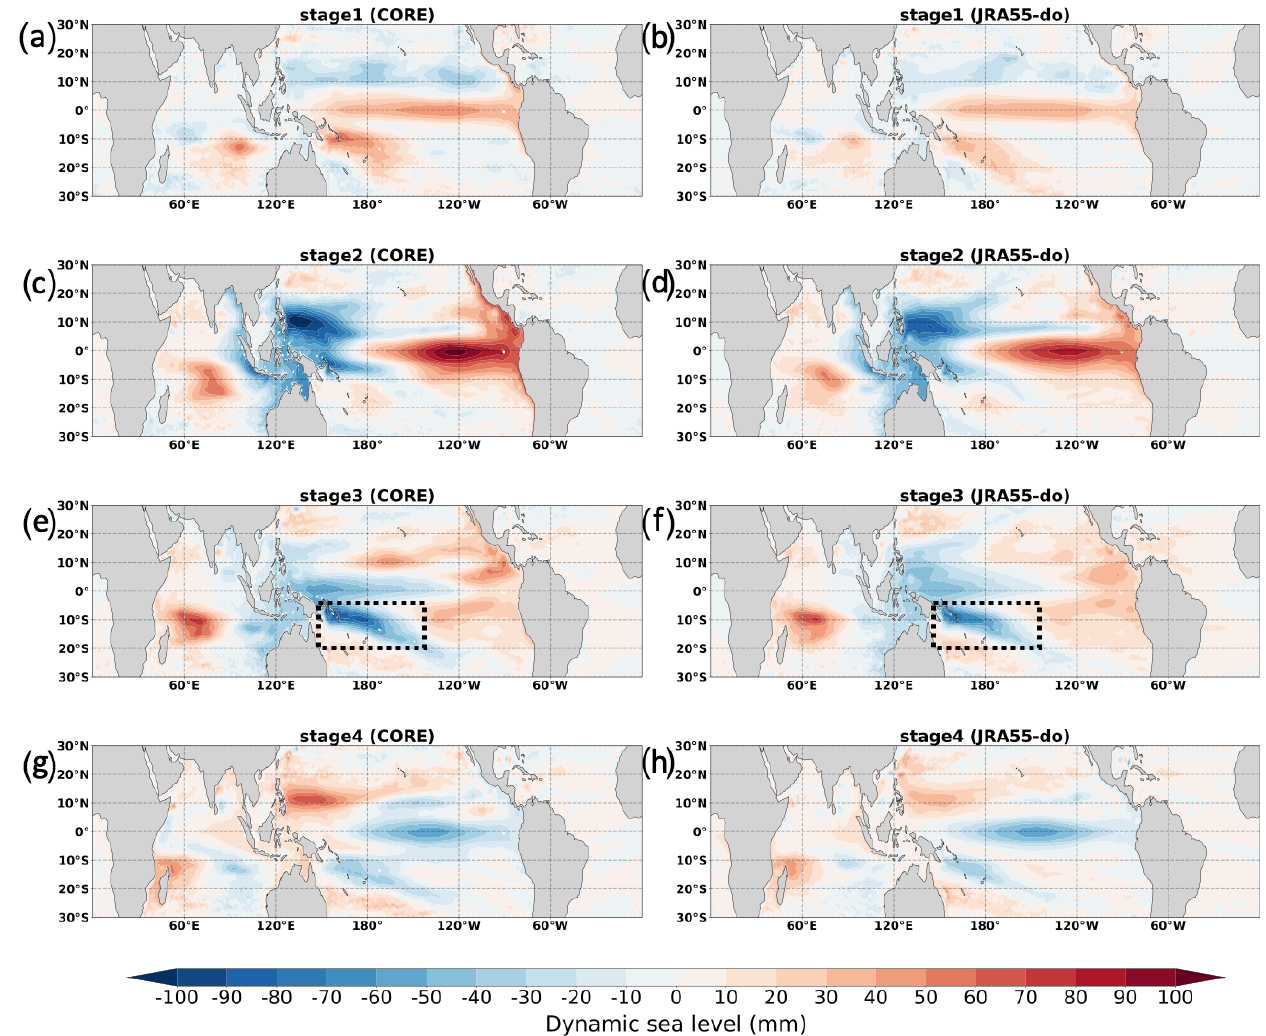
Figure 24. The DSL anomaly during the El Niño composite as determined during 1958–2007 in four different stages. The first row shows the first stage (the mean of 7–12 months prior to the maximum ONI value) in (a) CORE and (b) JRA55-do. The second row shows the second stage (the mean of 6 months prior to the maximum ONI value) in (c) CORE and (d) JRA55-do. The third row shows the third stage (the mean of 6 months following the maximum ONI value) in (e) CORE and (f) JRA55-do. The dashed black boxes show the region of asymmetric sea level changes in the southwestern tropical Pacific. The last row shows the fourth stage (the mean of 7–12 months following the maximum ONI value) in (g) CORE and (h)